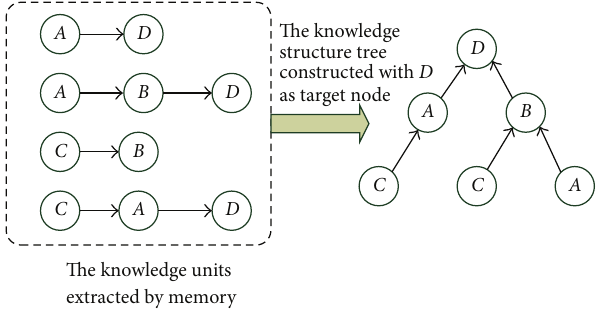
Figure 3: The assembling process of knowledge structure